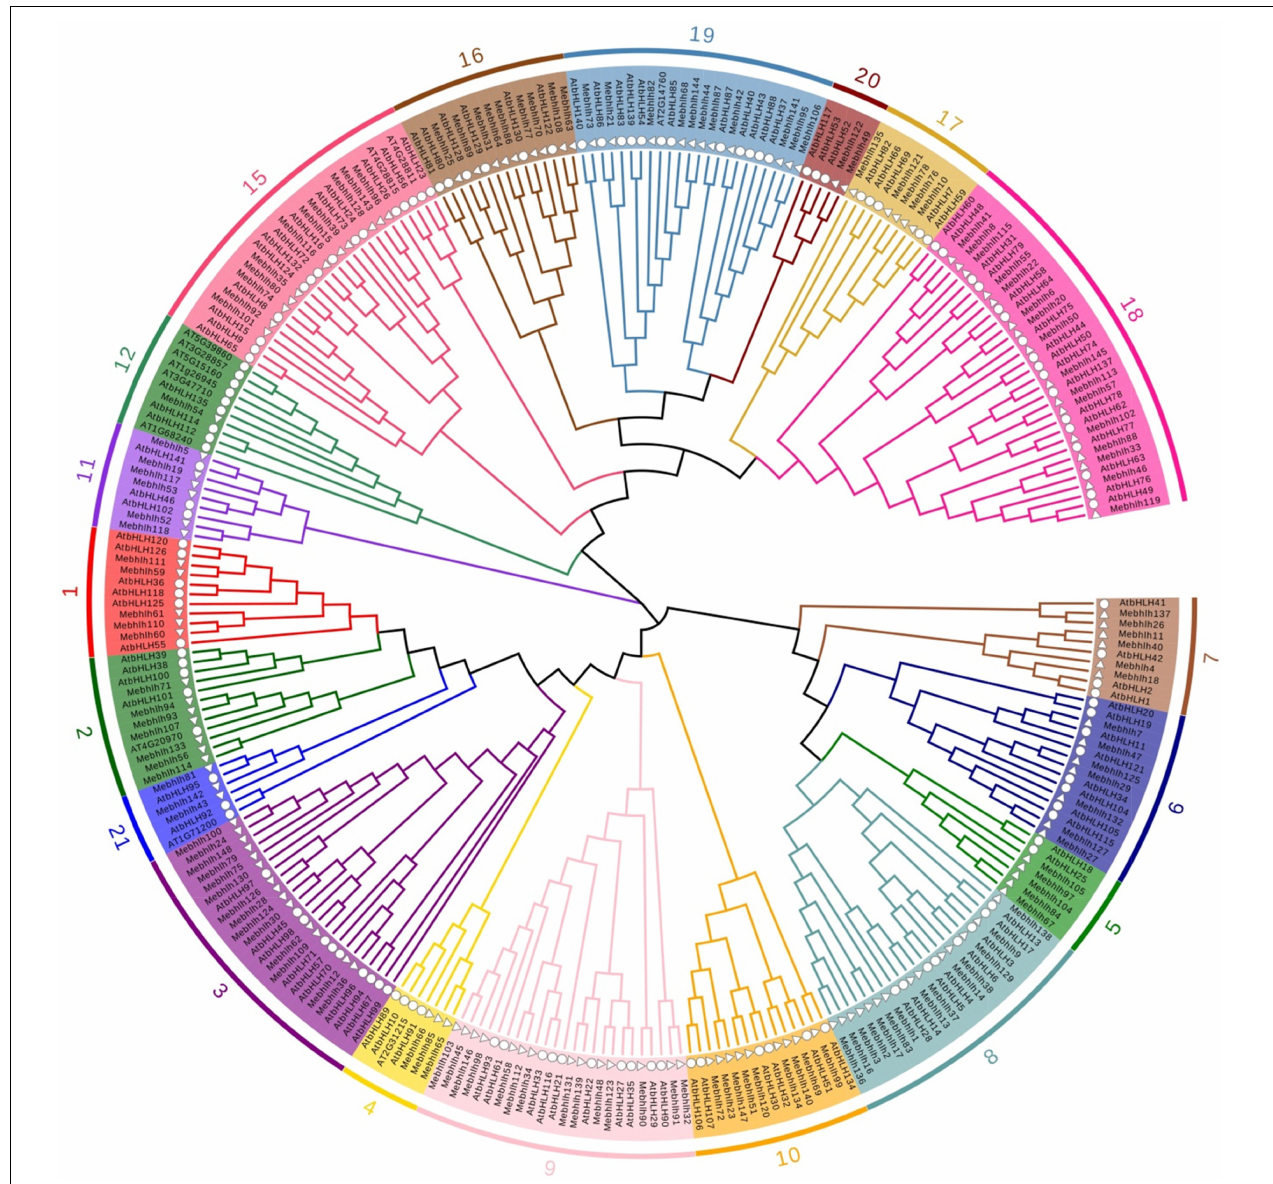
FIGURE 1 | Phylogenetic tree of the 148 MebHLH proteins. Multiple sequence alignment of bHLH domain sequences of M. esculenta and A. thaliana was performed using Clustal W. MEGA X was used to construct the neighbor-joining (NJ) tree with 1,000 bootstrap replicates. (cid:49) indicate bHLHs in M. esculenta ,